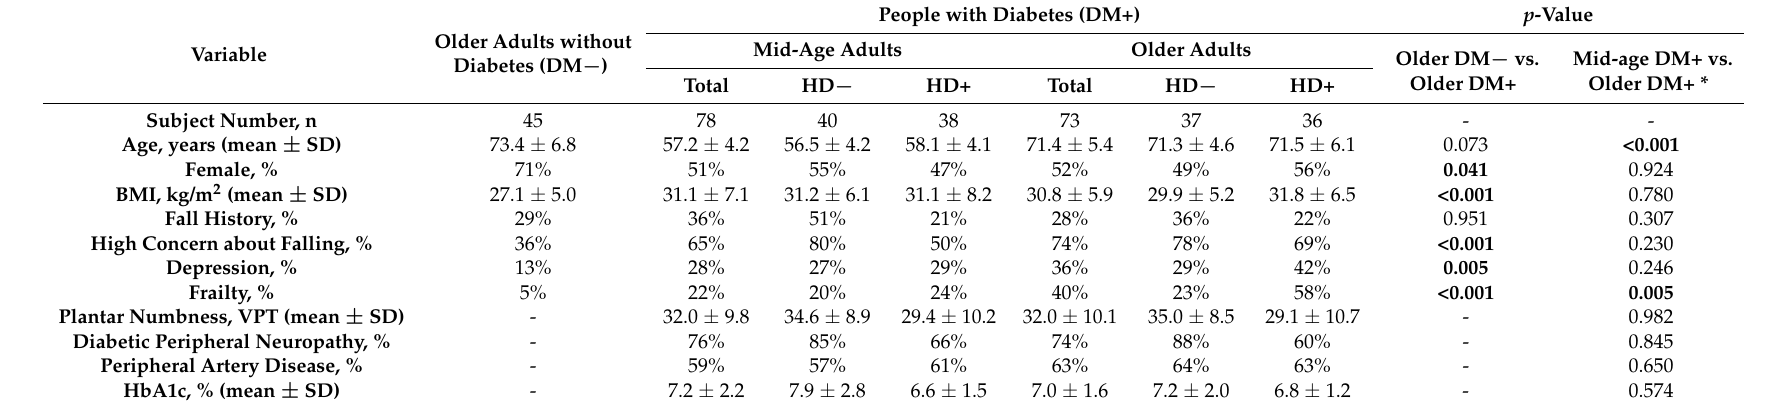
Table 1. General characteristics of the study